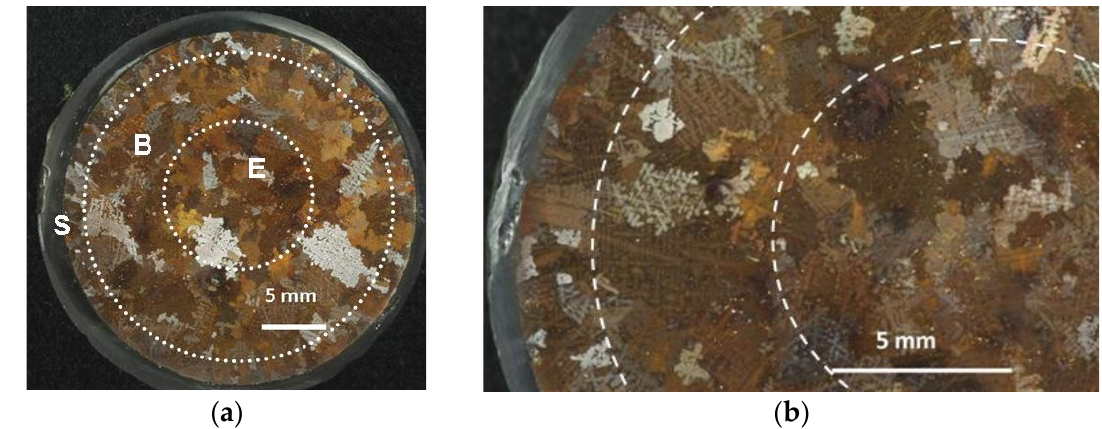
Figure 1. Macro ‐ photographic documentation of ZB reference alloy after colour etching with Klemm II reagent: ( a ) the whole specimen surface; ( b ) detail of previous depicting the dendritic structure inside the grains. The dotted lines highlight the boundaries between the distinct zones of the solidification process (where S: skin, B: basaltic area and E: equiaxed grains